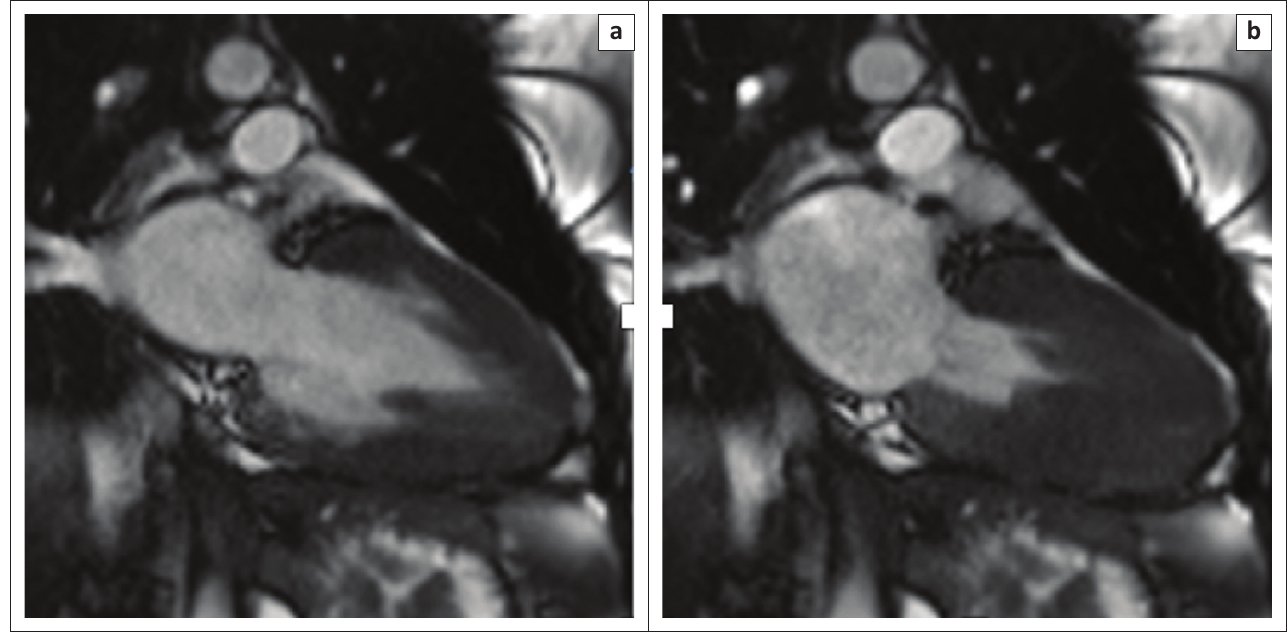
FIGURE 1: Relative apical hypertrophy, seen in two-chamber view in diastole (a) and systole (b). Note also the basal inferior crypts.